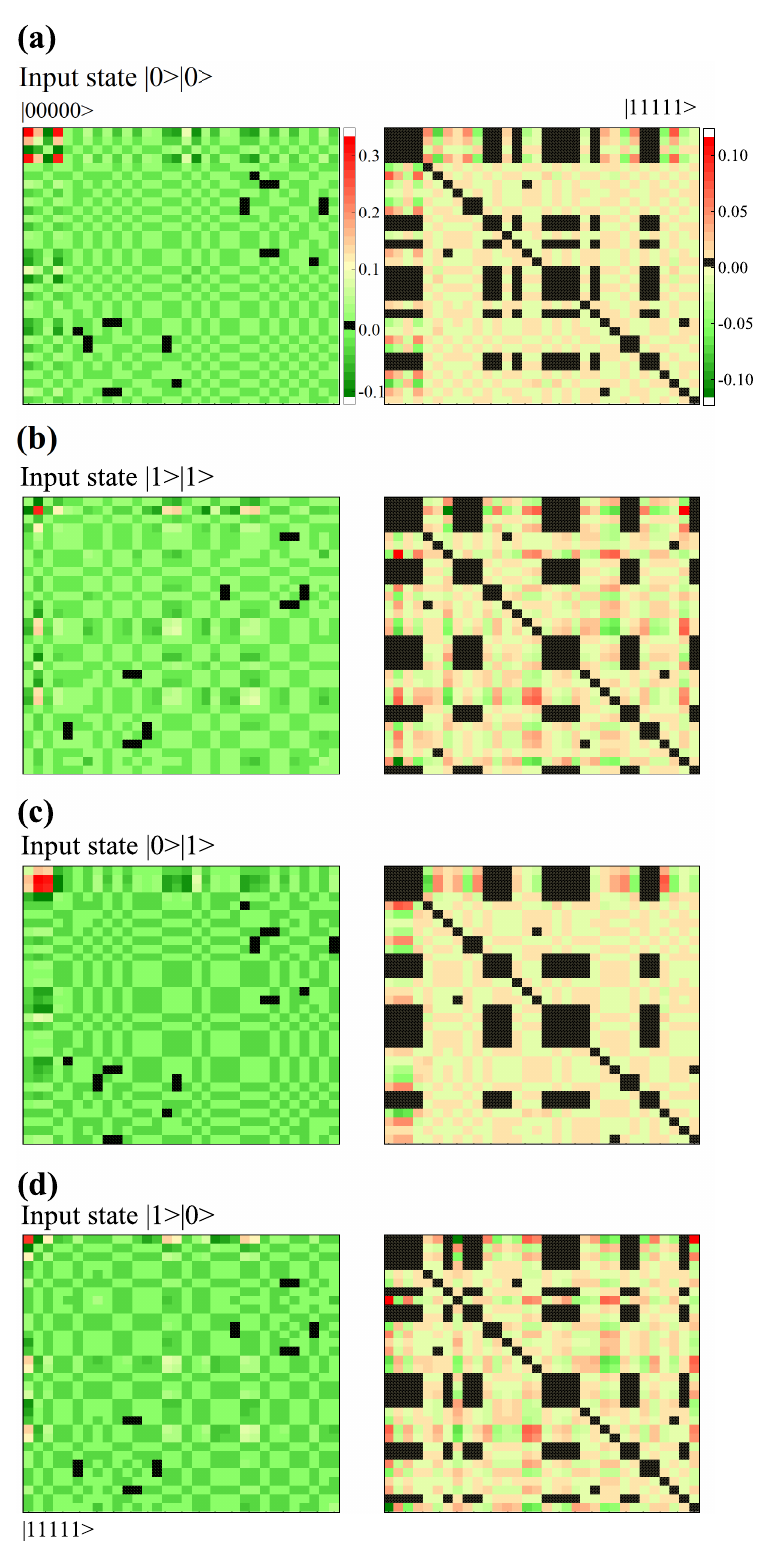
(cid:78) 3 | (cid:78) 3 | 00 (cid:105) ( a ), | 0 (cid:105) 01 (cid:105) ( b ),